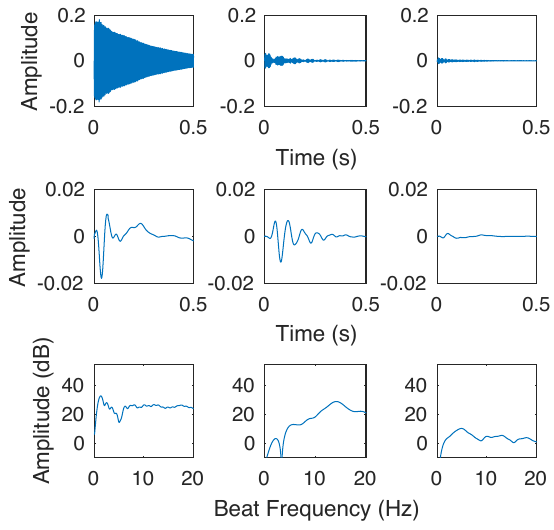
Figure 7. Beating analysis of octave Bb5–Bb6 tuned using rule m1.